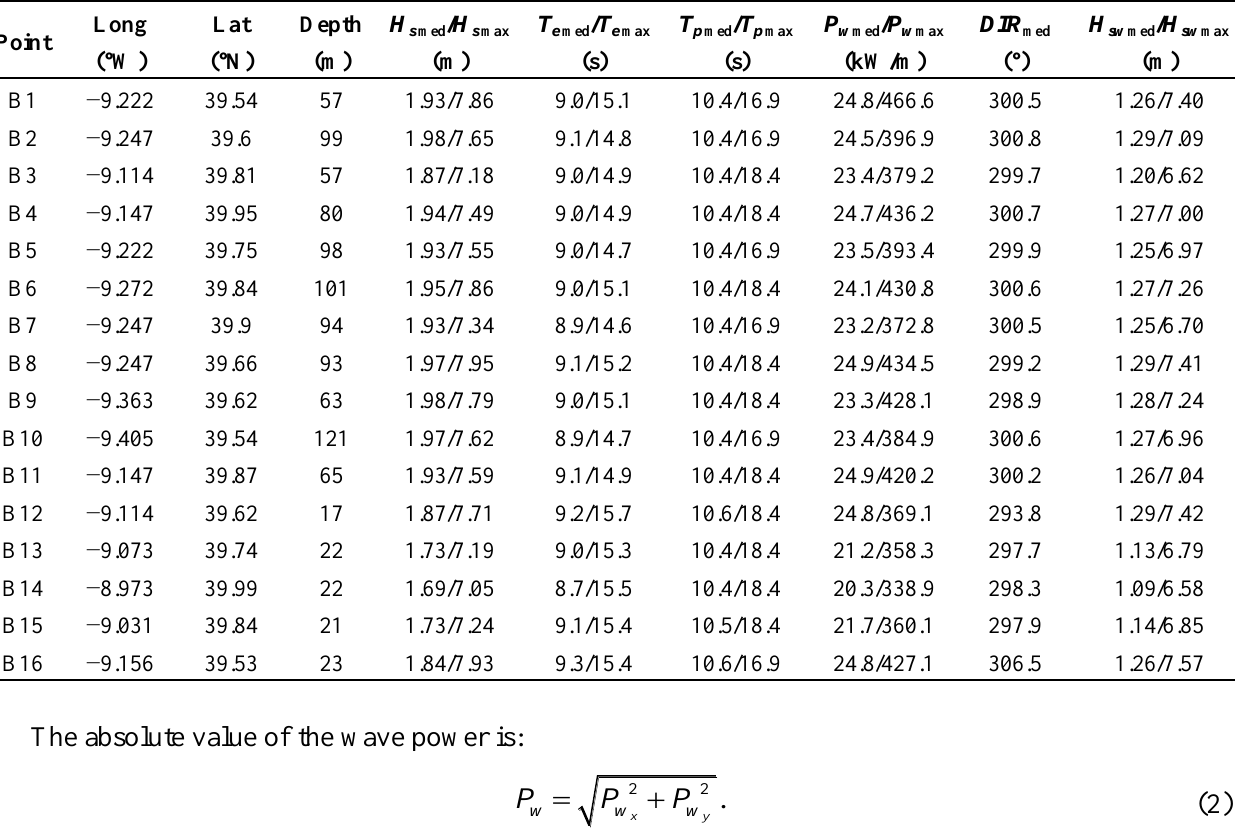
Table 2. Average (and maximum) values for the main wave parameters in the reference points from the central computational domain (B-points) as resulting from the simulations performed in the three-year period 2009–2011 (for total